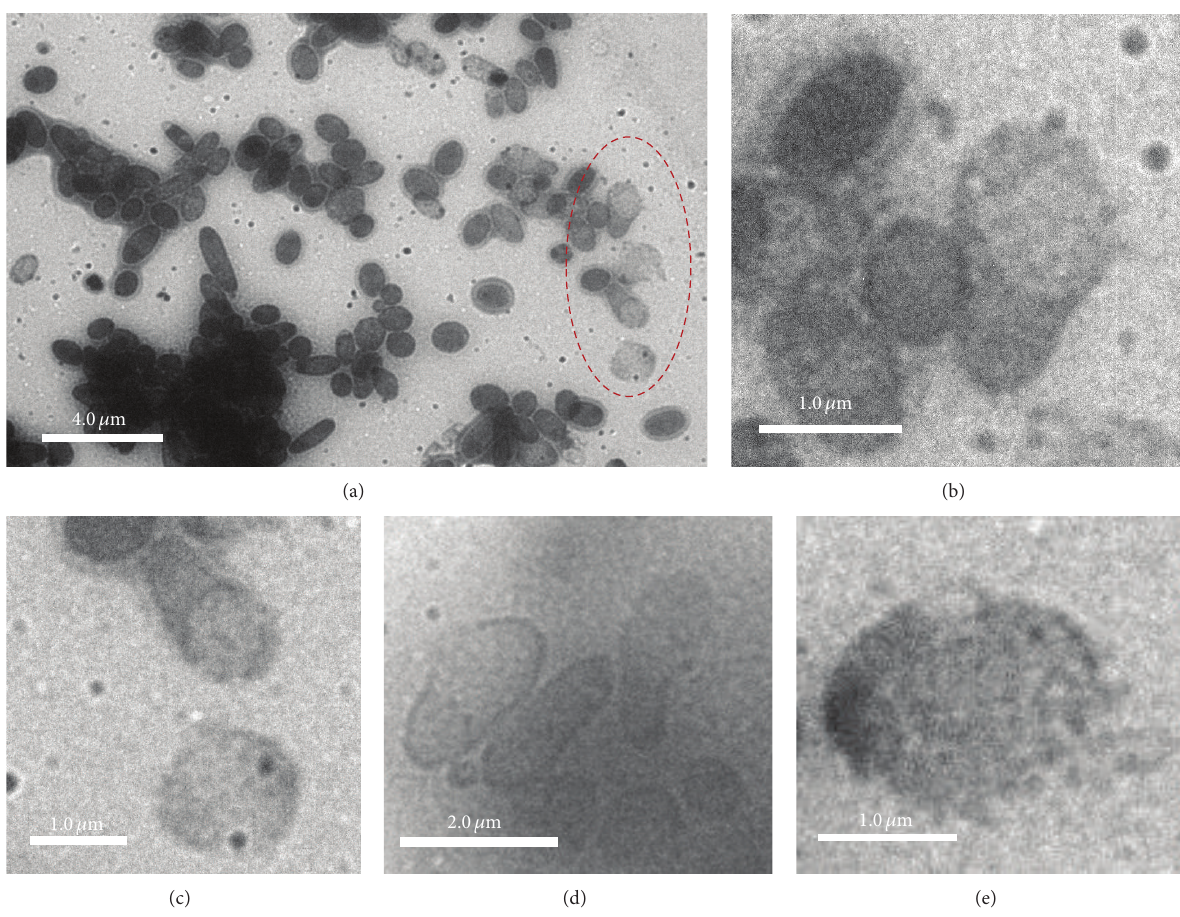
Figure 3: In situ TEM images showing the ruptured E. coli cells: (a) in a large area image and (b) in the magnification area from the red circular labeled region in (a) that shows a ruptured cell; (c) two ruptured cells from (a) beneath the circular region; (d) and (e) are in situ TEM images showing different ruptured